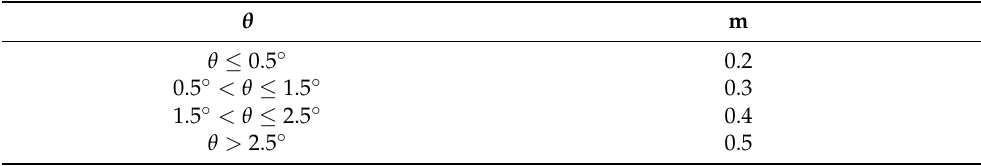
Table 3. The values of slope length factor index